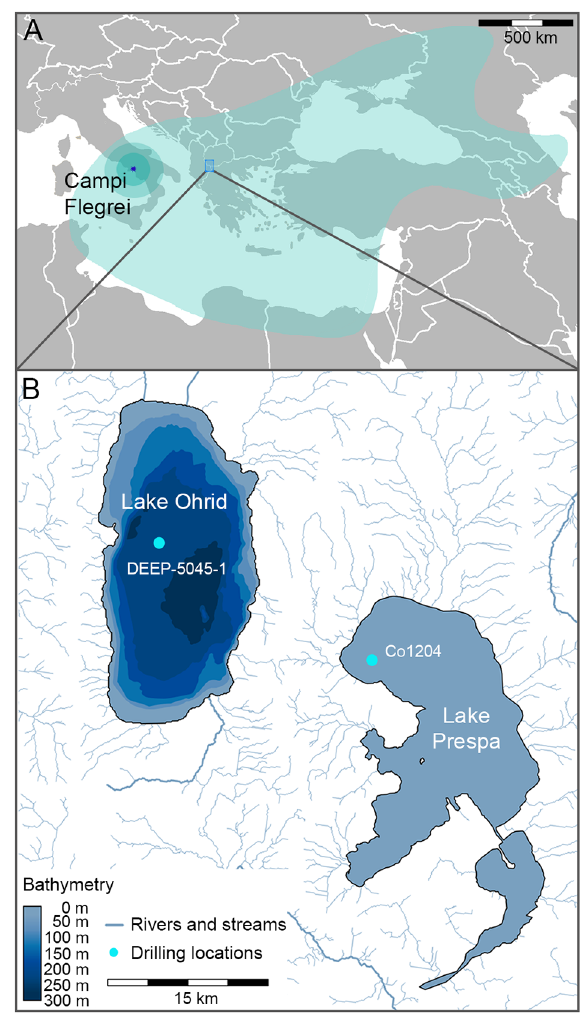
Figure 1. Maps showing (a) the Y-5 tephra distribution from the Campi Flegrei caldera (blueish-green shading; area as defined by Fitzsimmons et al., 2013) and (b) the drilling sites in lakes Ohrid (DEEP-5045-1) and Prespa